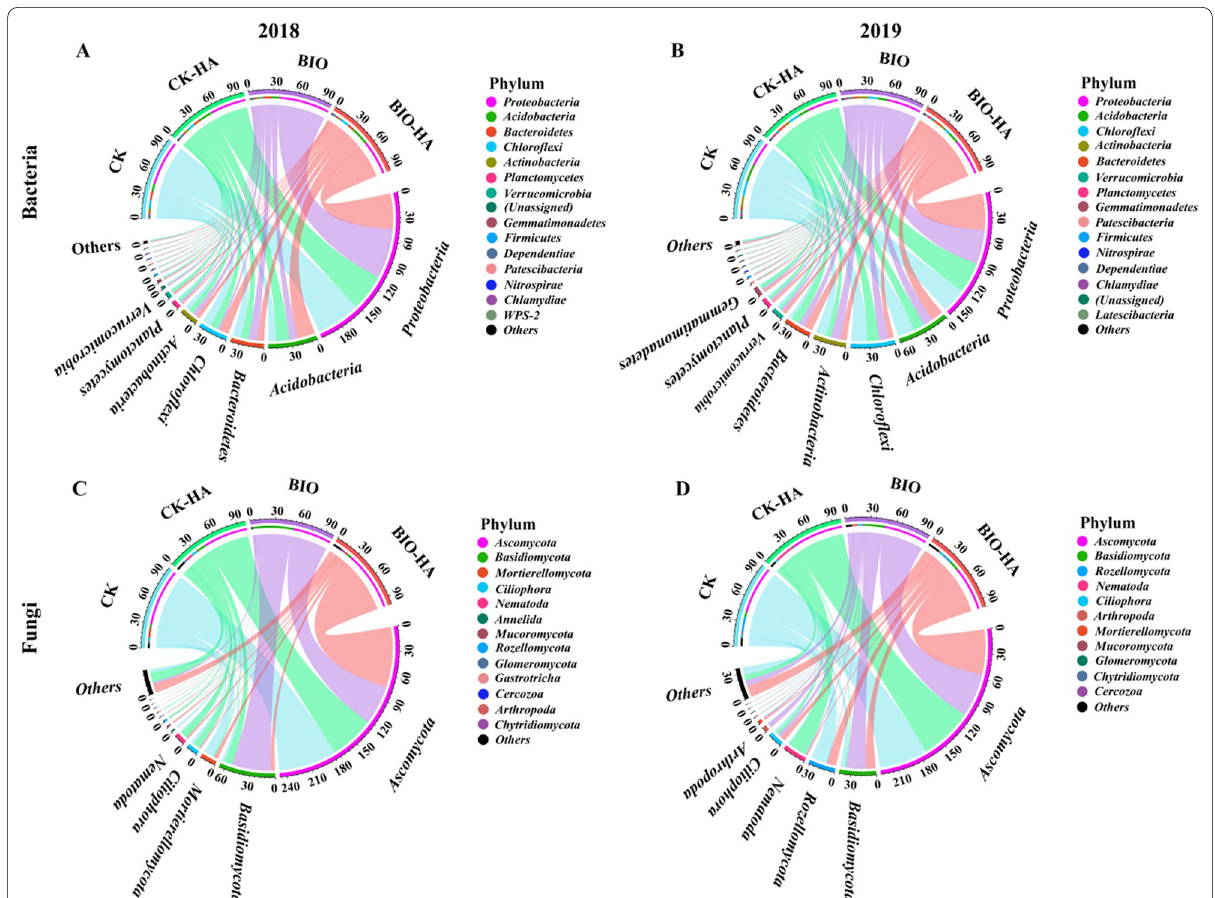
Fig. 3 Relative abundance of the 15-dominant bacterial ( A and B ) and fungal ( C and D ) phyla 2018–2019. The change in the width of the color band indicates the change in relative abundance. CK, conventional fertilization; CK-HA, conventional fertilization combined with humic acid; BIO, bio-organic fertilizer; BIO-HA, combined application of BIO and